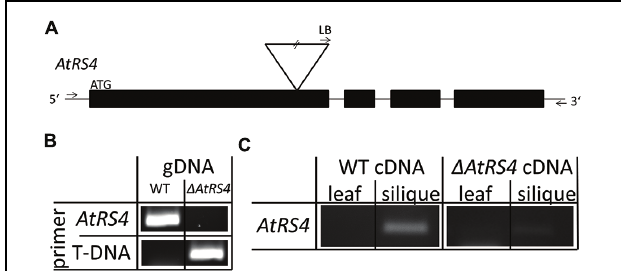
FIGURE 9 | (cid:2) AtRS4 mutant plant analysis. (A) Shows the localization of T-DNA insertion site in (cid:2) AtRS4 mutant plants. Exons are represented by black boxes and introns by lines. T-DNA is depicted by an inverted triangle. (B) Insertion of T-DNA was determined by PCR product obtained from gDNA of WT and (cid:2) AtRS4 mutant plant leaves. (C) Semi-quantitative PCR (sqPCR) of reverse transcribed cDNA from siliques as well as from leaves of WT and (cid:2) AtRS4 mutant plants.